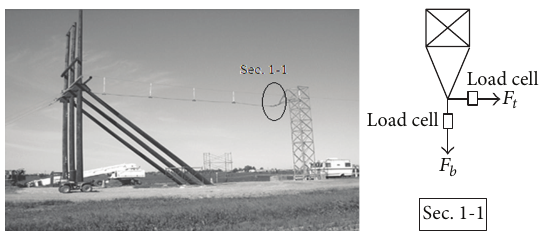
Figure 7: Experimental test site of Lee and McClure [19] tower.